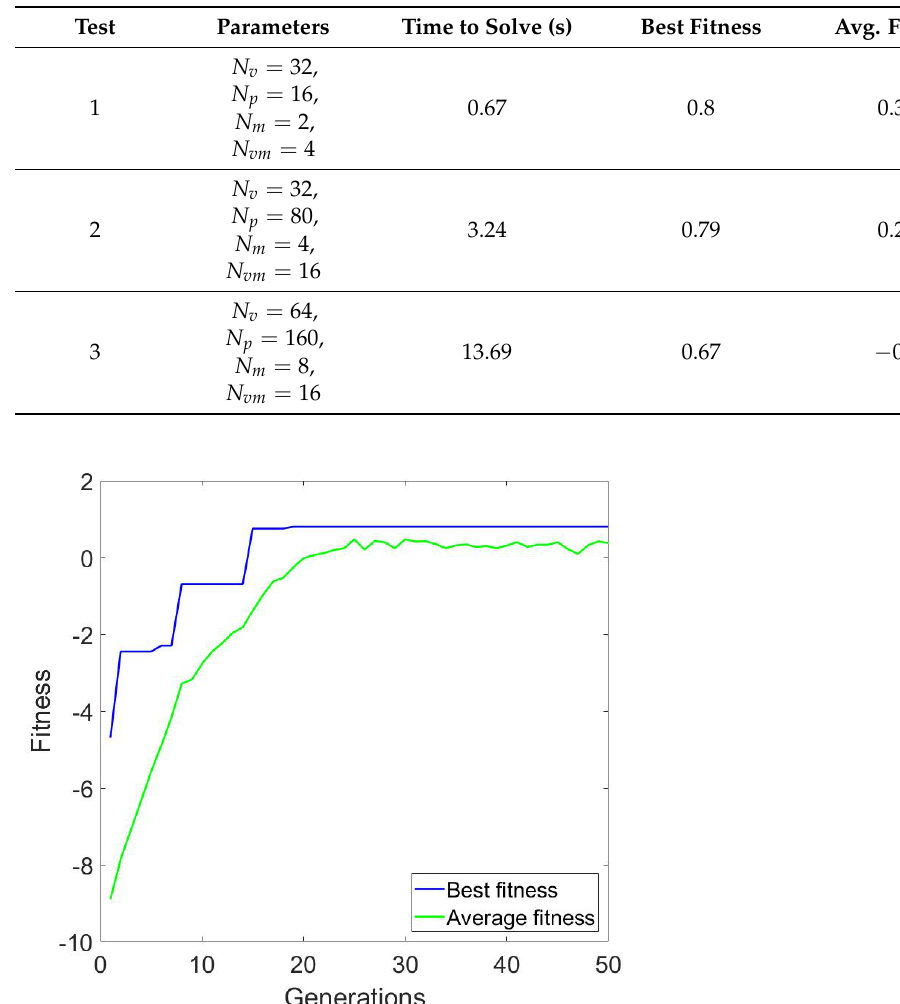
Table 2. Experiment 1. GP algorithm using objective function without penalties for suboptimal NUMA mappings.